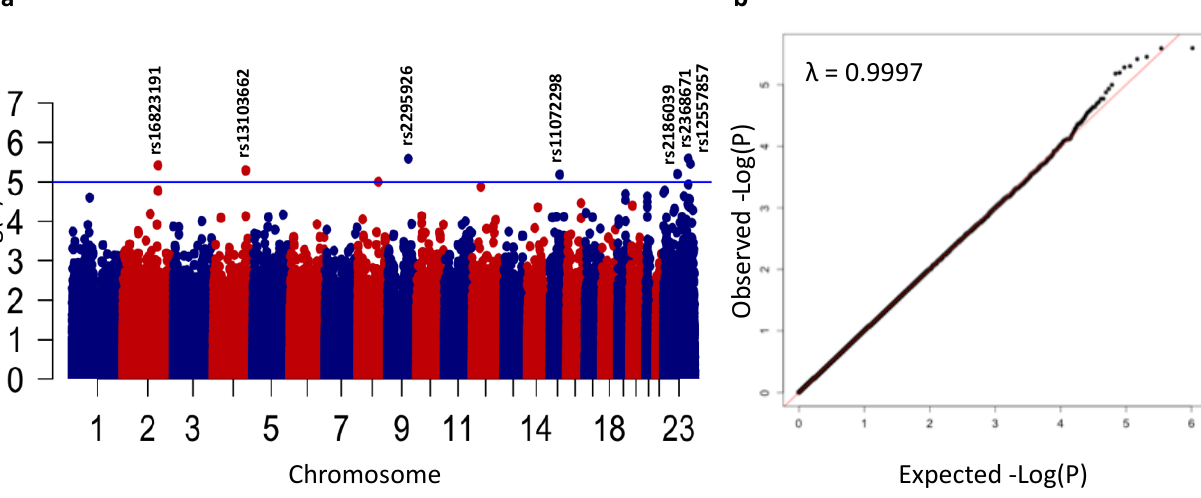
Figure 2. Manhattan and quantile-quantile plots. ( a ) Manhattan plot of association test results showing the chromosomal position of 516,320 analyzed SNPs plotted against − log ( p ). The blue horizontal line represents the threshold for suggestive evidence of association ( p < 1 × 10 −5 ). ( b ) Quantile-quantile plot showing the expected versus observed − log ( p ) values. The genomic inflation factor (λ) is shown at the top left corner.